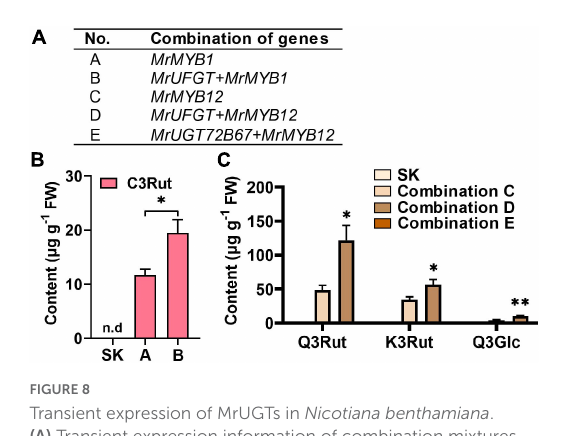
FIGURE8 Transient expression of MrUGTs in Nicotiana benthamiana . (A) Transient expression information of combination mixtures. (B) Analysis of anthocyanins in N. benthamiana leaves infiltrated with combinations contained MrUFGT. (C) Analysis of flavonol glucosides in N. benthamiana leaves infiltrated with combinations contained MrUFGT or MrUGT72B67. Leaves infiltrated with empty SK vector were used as control. Products were confirmed by LC-MS/MS. Data are mean ± SE ( n = 3).